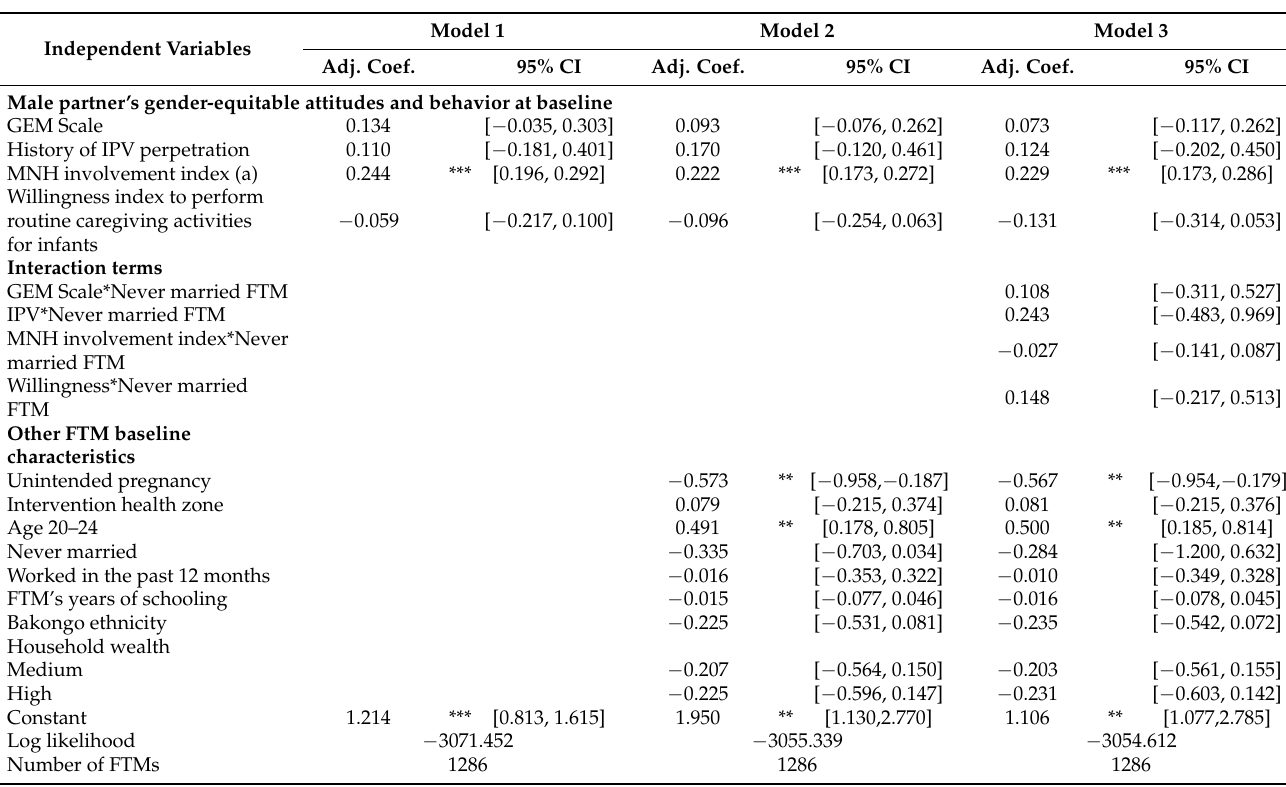
Table 6. Results of multivariable linear regression models of the index of shared decision making